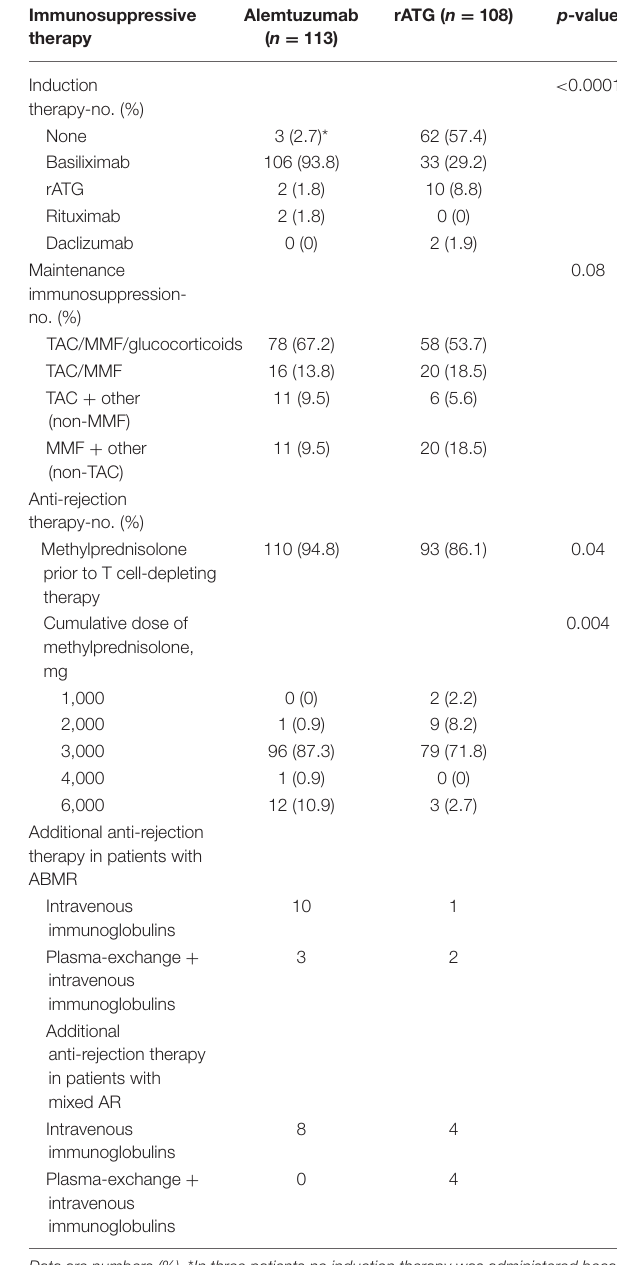
rATG (n = 108) p -value ( n = 113)